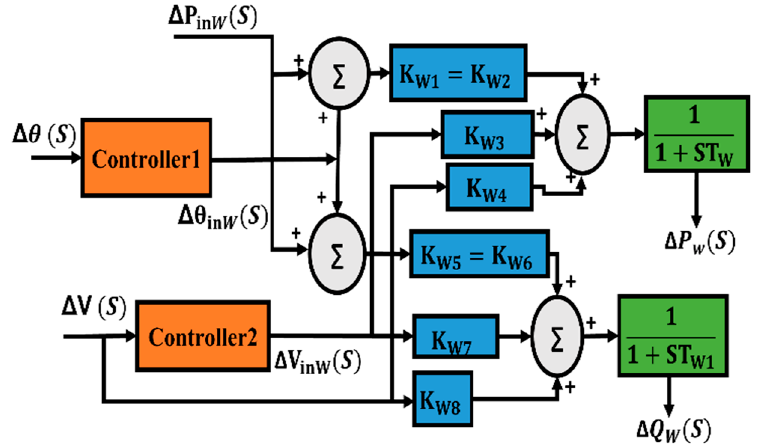
Figure 2. SLD of WECS.